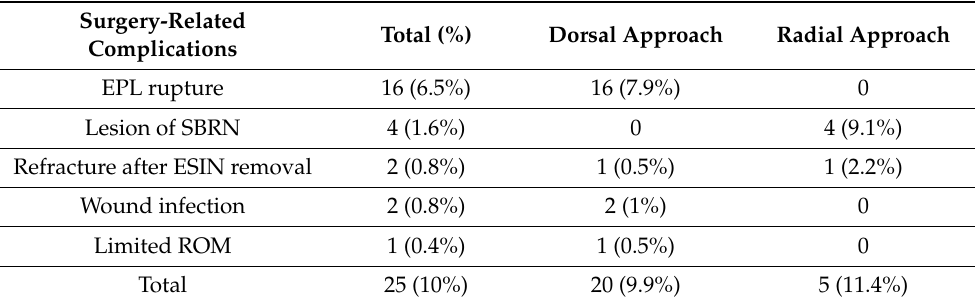
Table 2. Surgery related complications (EPL = extensor pollicis longus, SBRN = superficial branch of radial nerve, ESIN = elastic stable intramedullary nailing, ROM = range of motion. Surgery-Related Complications Total (%) Dorsal Approach Radial Approach